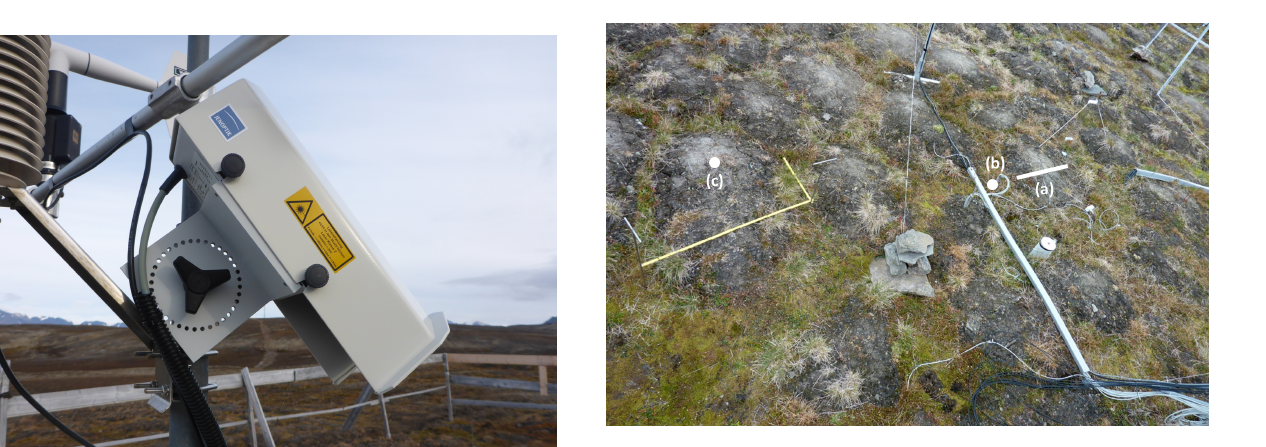
Figure C7. Soil profile and station location (a) 1998, (b) 1999 and (c) 2009. (b) Upper temperature sensors were affected by reindeer disturbance in September 2003. Furthermore, the temperature sen- sors were affected by continuous frost heave by about 10cm be- tween 2003 and 2015.